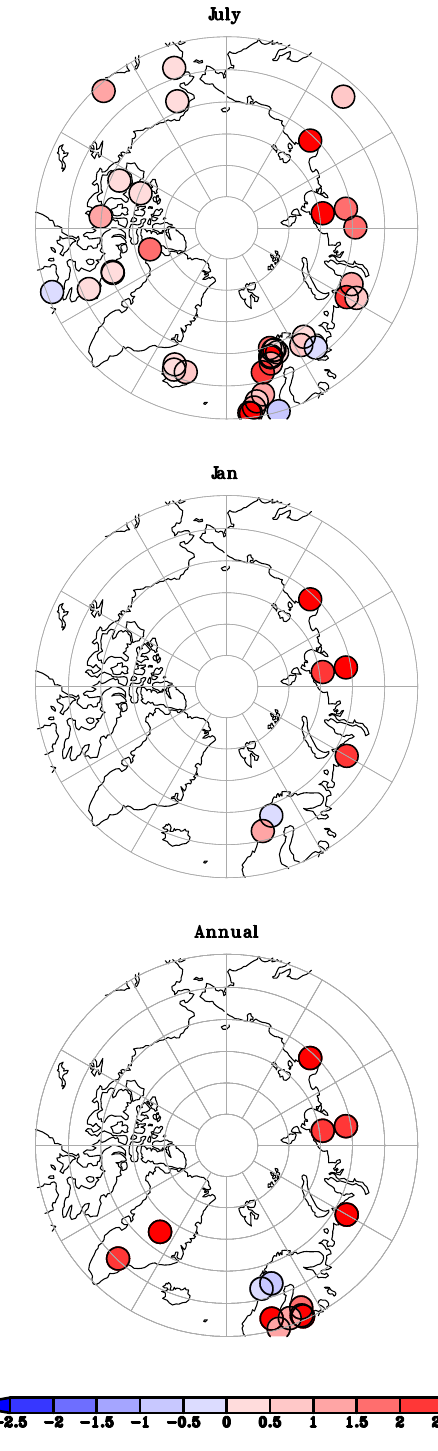
Fig. 3. Map of the estimated difference in temperature (annual, July, January) between 6ka and 0.5ka at the different proxy sites over the northern high